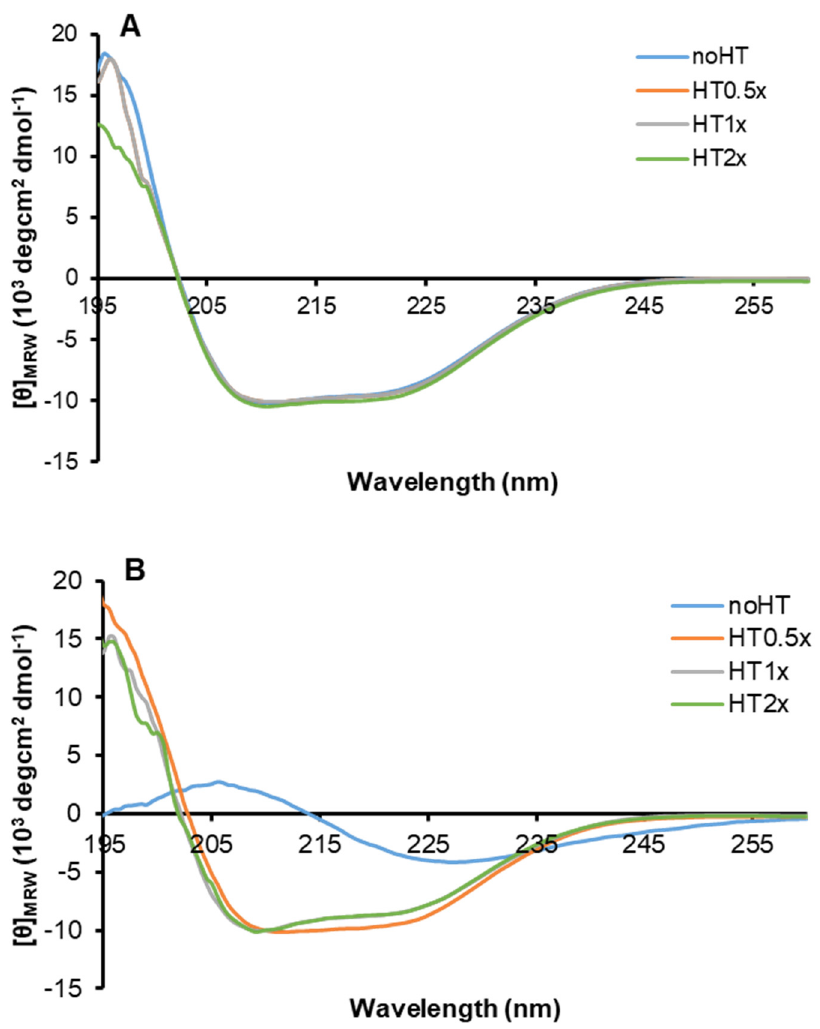
Figure 3. Effect of HT on insulin amyloid formation. Far-UV CD spectra of insulin in aggregating conditions in the absence and in the presence of HT 0.5, 1, and 2× molar ratio at 0 ( A ) and 24 ( B ) hours of incubation. Protein concentration was 0.3 mg/mL, other experimental details are described in the Methods section.